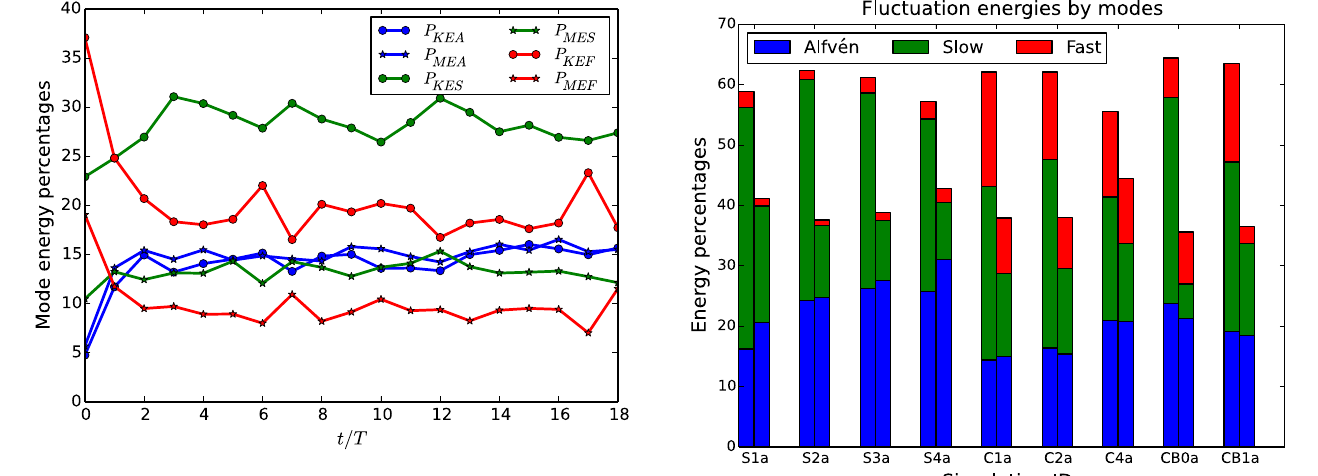
FIG. 1. Fraction of mode energies in the velocity and magnetic fields of the different MHD modes for the C1a simulation as a function of time.